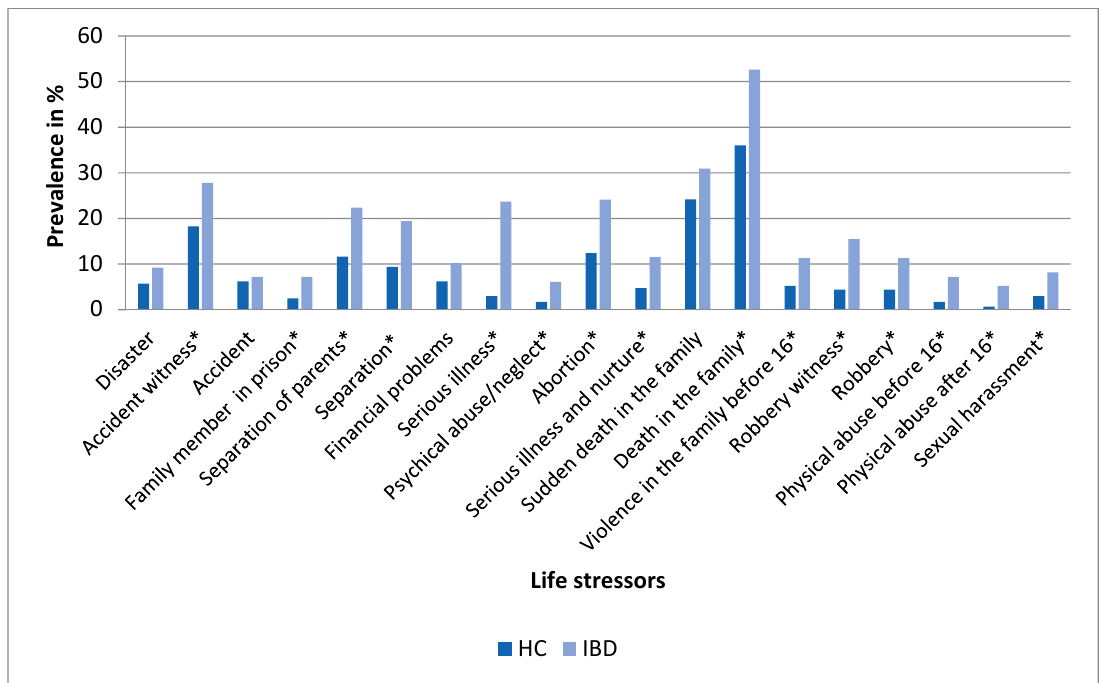
Figure 2. Prevalence of life stressors (%) in the healthy control group (HC, N = 405) and in patients with inflammatory bowel disease (IBD, N = 98). Differences in the occurrence of individual life stressors between the groups were assessed by a test of proportions (Z-test); * p < 0.05. Life stressors with low prevalence are not presented.